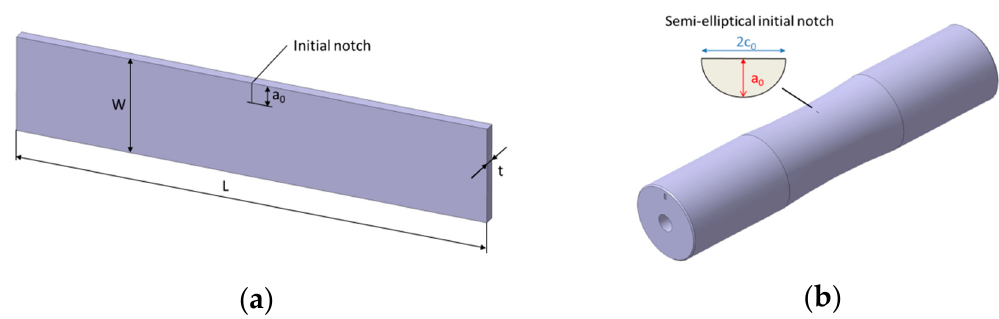
Figure 3. ( a ) Illustration of the investigated single edge notch bending (SENB) specimen with straight initial notch and ( b ) 1:3-scaled axle specimen with semi-elliptical initial notch.